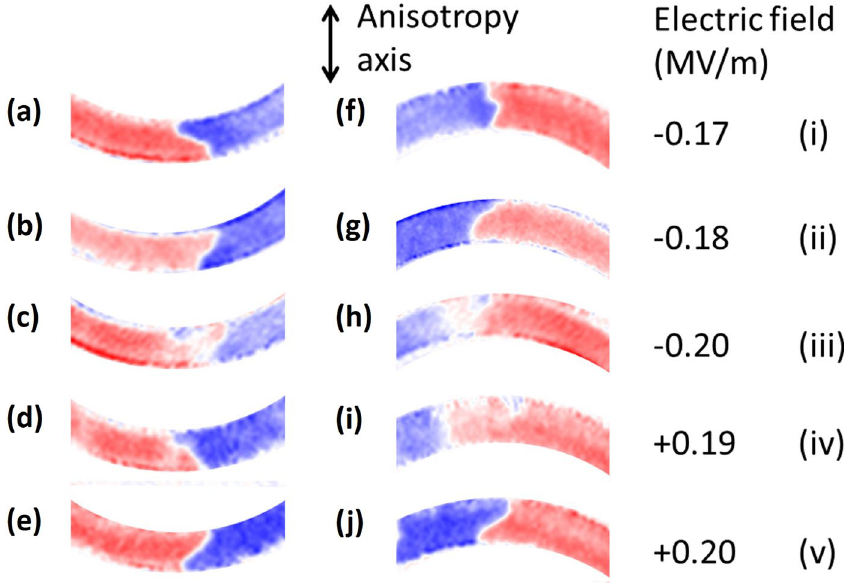
Figure 2. XMCD-PEEM images of strain-induced chirality switching in vortex domain walls. Red shading represents magnetisation pointing from right to left. Blue represents magnetisation pointing from left to right. Panel sequences ( a ) to ( e ) and ( f ) to ( j ) show the evolution of a tail to tail and head to head vortex wall respectively as a function of the electric field applied to the PMN-PT. The axis of the induced uniaxial anisotropy is represented by the arrow. Roman numerals correspond to the electric fields labelled in Fig.